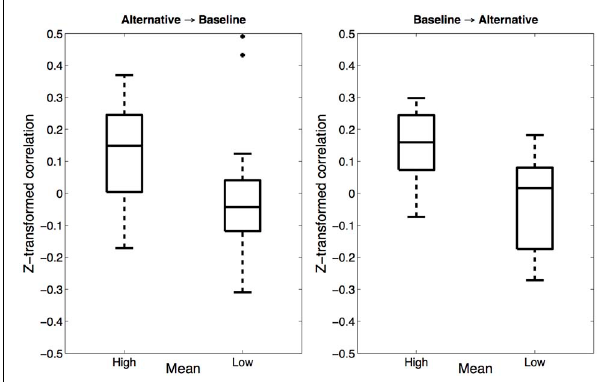
FIGURE 3 | Trial-wise correlations in Experiment 1. Left : Fisher z-transformed correlations between estimates on baseline trials and on the preceding alternative trials. Right : Correlations between alternative trials and the preceding baseline